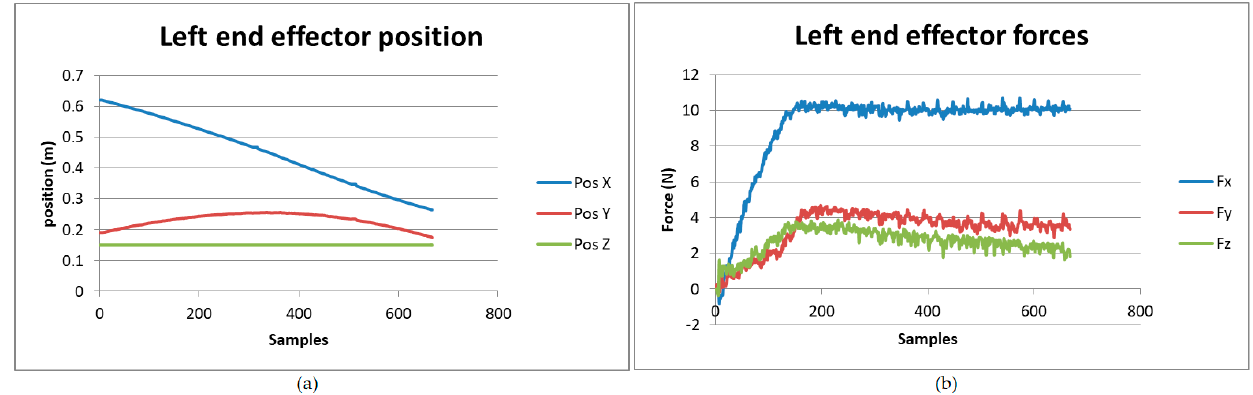
Figure 16. ( a ) Frontal force needed to move the box over the surface, depending on its weight. ( b ) Calculus of the friction coefficient of the box, depending on the weight.